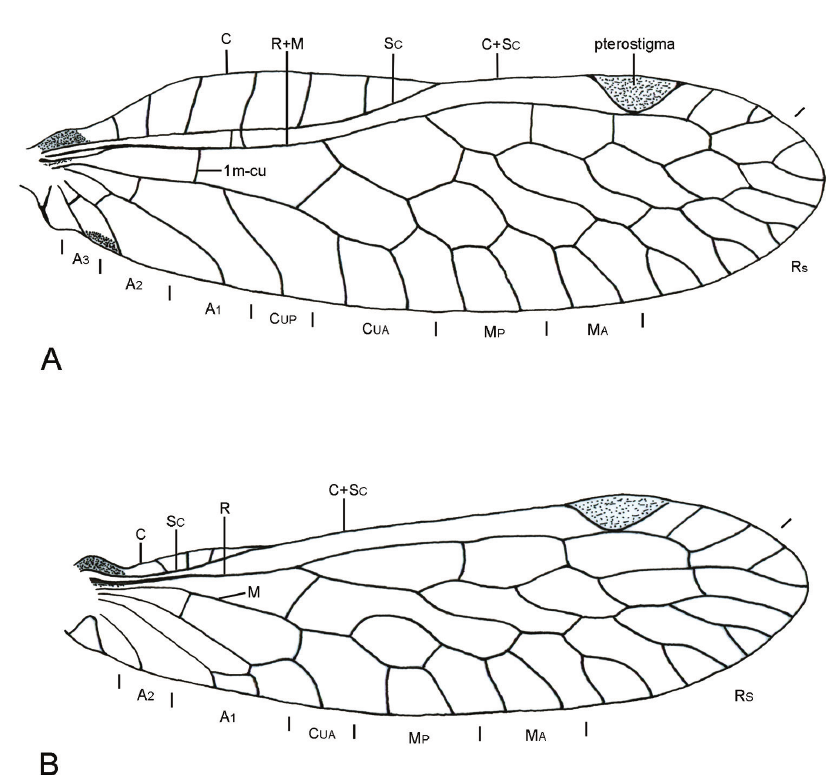
Figure 4. Wing venation of Nolima pinal . A forewing B hindwing.